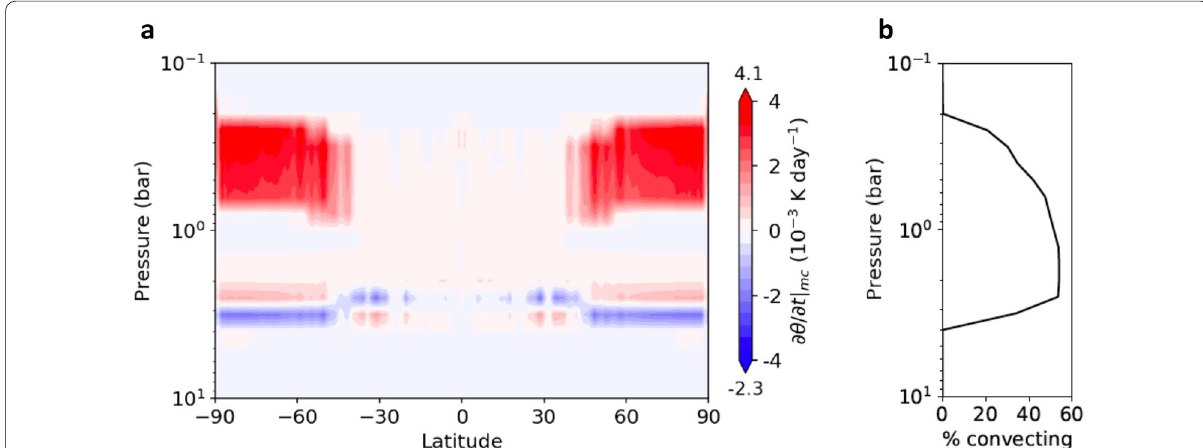
Fig. 7 Distribution of moist convection in a Jason simulation of Jupiter’s weather layer at a resolution of 0.7° and Read 2020), showing ( a ) the net rate of change of humidity as a function of latitude and pressure, and ( b ) the fraction of convecting grid points as a function of pressure, showing the confinement of moist convection between ~ 4 bars and 200